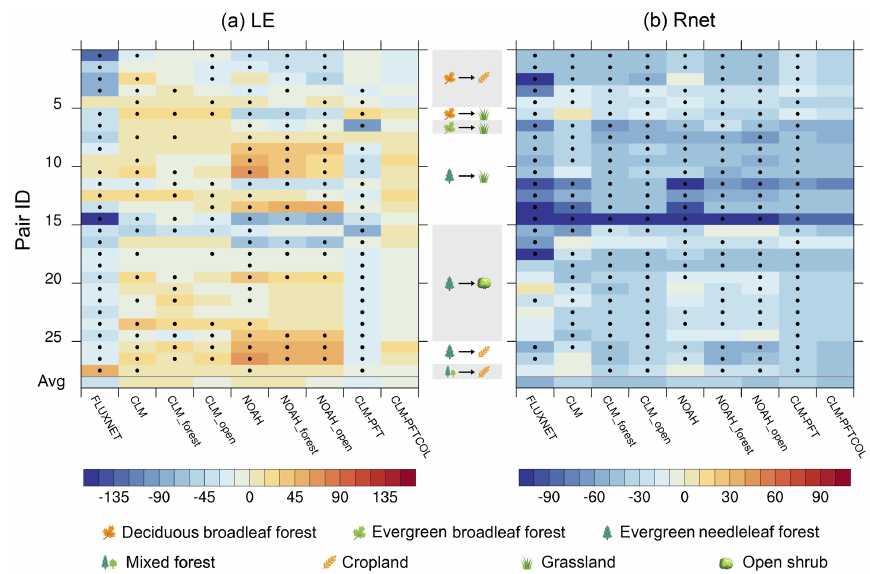
Figure 10. Change (open − forest) in observed and simulated LE (a) and R net (b) during summer daytime (averaged during the period 08:00–16:00) over individual pairs and their averages. The vertical labels show the pair IDs from 1 to 28 based on Table S1. The pairs are grouped based on the type of LULCC (shown as the icons in the middle). The bottom row is the average over all pairs. The Student’s t test is performed on the daily (daytime average) time series for each pair. Dots indicate statistically significant changes at the 95% confidence level. No significant test is carried out for the CLM-PFTCOL simulation (the last column), because we only have long-term averaged hourly output for each